Question: According to the figure, is the described quantity increasing or decreasing?
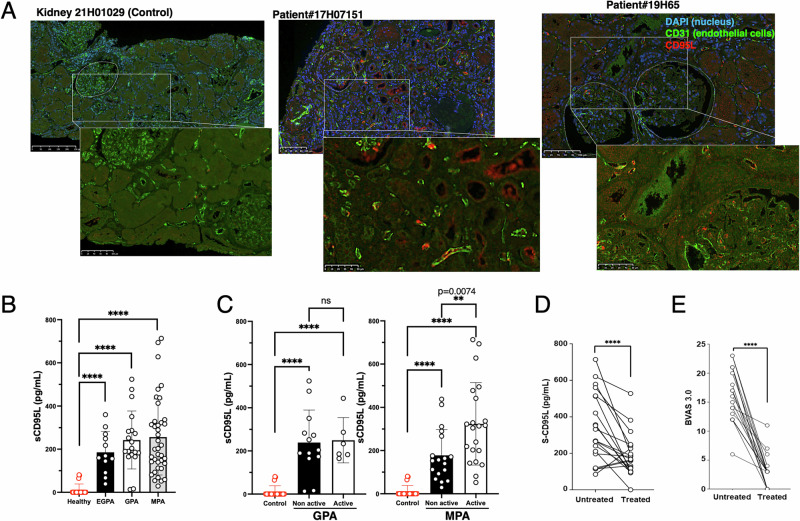
Answer: increasing